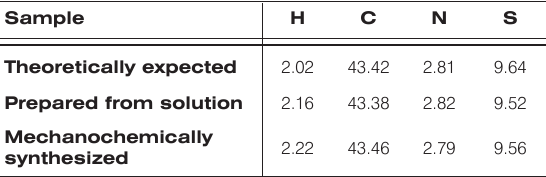
Table 1. Elemental composition (%) of Eu(TTA)